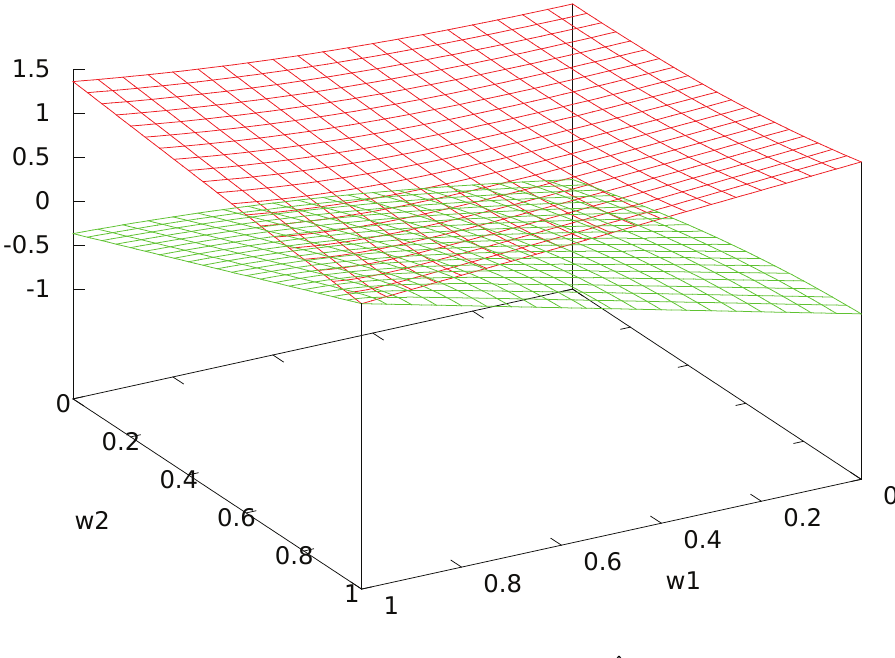
Figure A1. Eigenvalues λ 1 , λ 2 of ˆ A